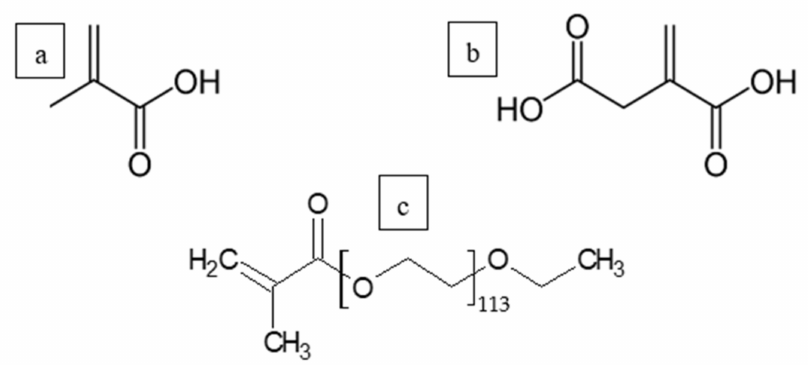
Figure 1. ( a ) methacrylic acid (MAA), ( b ) itaconic acid (ITA) and ( c ) polyethyleneglycol methacrylate (PEGMA) functional monomers.